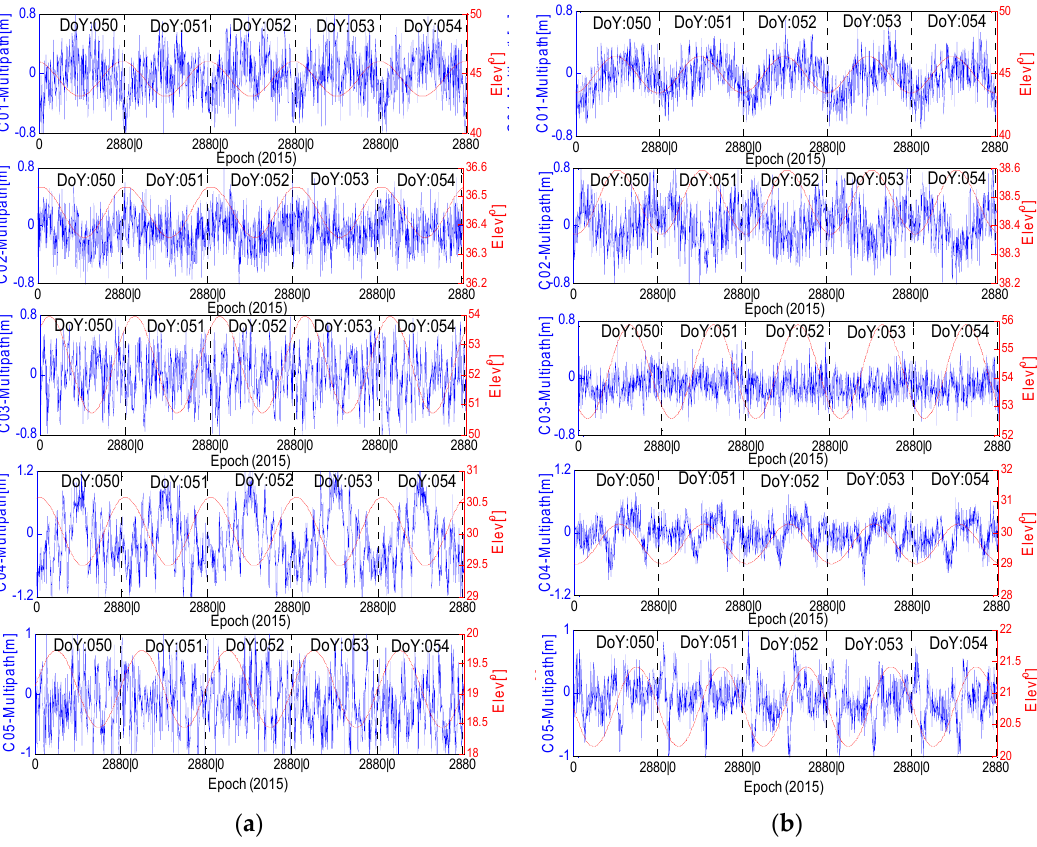
Figure 4. The relationship between MP series and elevations for GEO satellites at station CUT0 ( a ) and JFNG ( b ). Blue represents the multipath series; red represents the elevations. The observation sampling rate is 30 s.